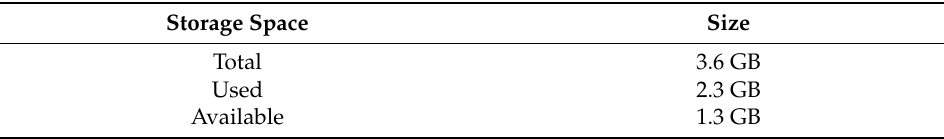
Figure 3. Illustration of group. Table 1. Storage space of the humanoid robot.